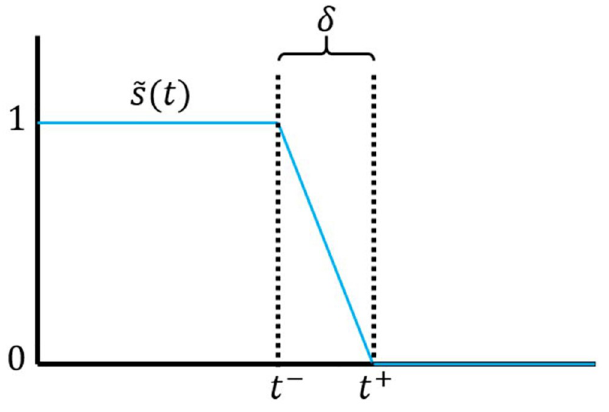
Fig 16. Modified continuous function ~ s ð t Þ